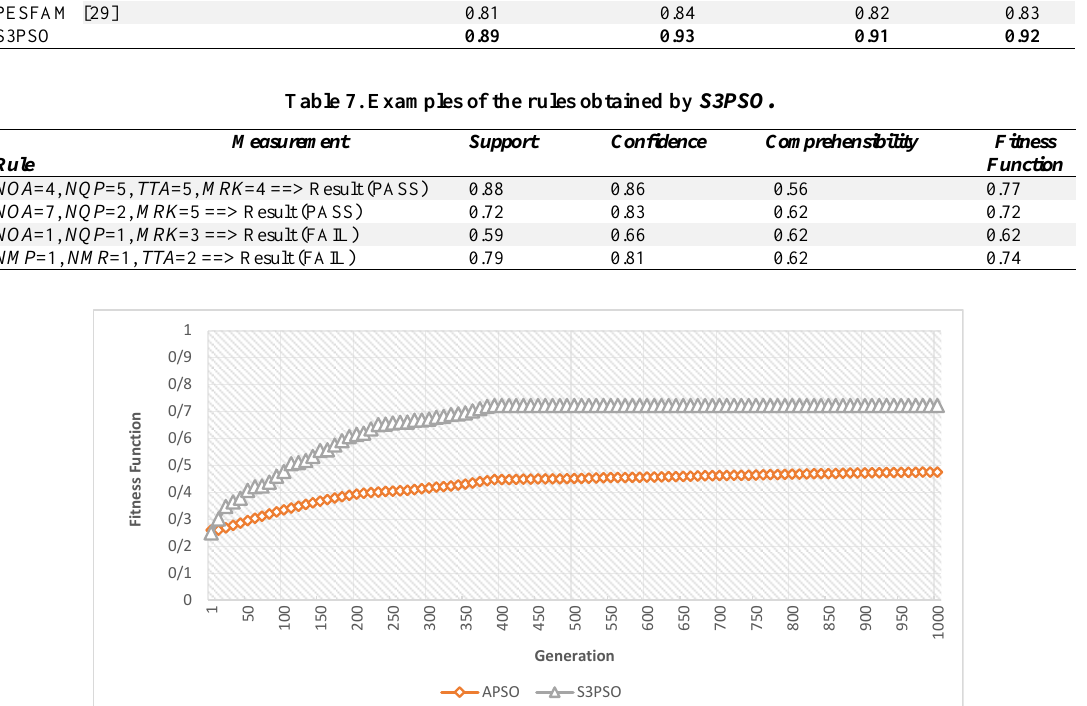
Figure 14. Comparing convergence of S3PSO and APSO